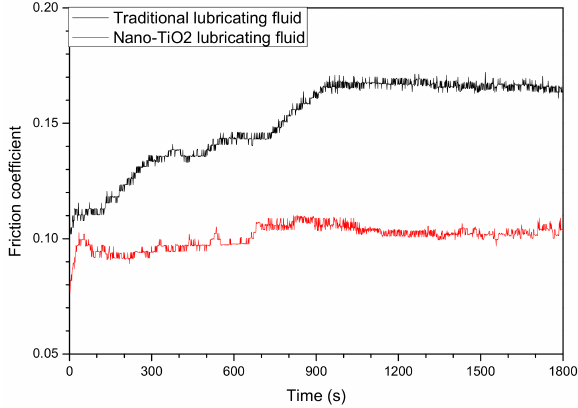
Figure 3. Friction coefficient-time curves of traditional lubricating fluid and nano-TiO 2